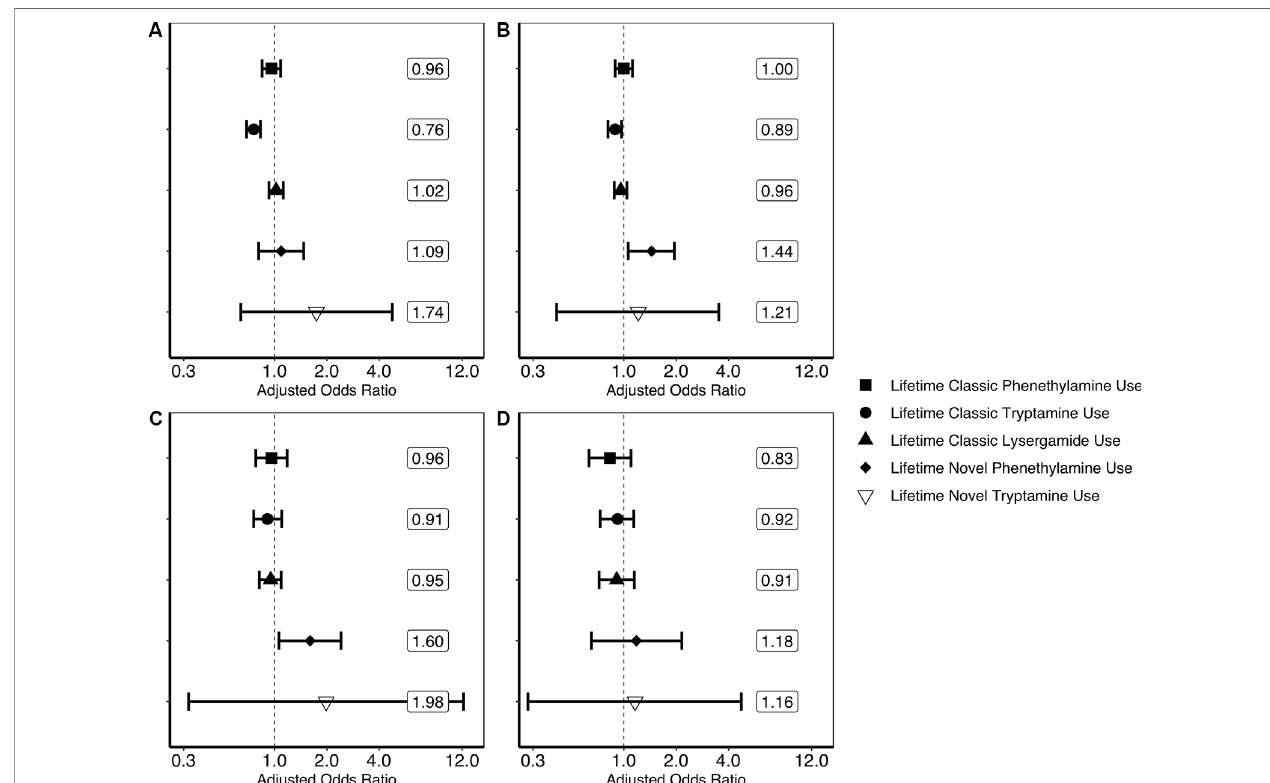
FIGURE 1 | Results of multivariate logistic regression models predicting past month psychological distress and past year suicidality. (A) Result of multivariate logistic regression model predicting past month psychological distress (unweighted n = 356,046). (B) Result of multivariate logistic regression model predicting past year suicidal thinking (unweighted n = 354,580). (C) Result of multivariate logistic regression model predicting past year suicidal planning (unweighted n = 354,555). (D) Result of multivariate logistic regression model predicting past year suicide attempt (unweighted n = 354,552). Each plotted shape relates to the drug category and represent weighted adjusted odds ratio point estimates and error bars are 95% con fi dence intervals. Associations are adjusted for the following covariates: age in years (12 – 17, 18 – 25, 26 – 34, 35 – 49, 50 – 64, or 65 or older); sex (male or female); ethnoracial identity (non-Hispanic White, non-Hispanic African American, non- Hispanic Native American/Alaska Native, non-Hispanic Native Hawaiian/Paci fi c Islander, non-Hispanic Asian, non-Hispanic more than one race, or Hispanic); educational attainment (5th grade or less, 6th grade, 7th grade, 8th grade, 9th grade, 10th grade, 11th grade, 12th grade, freshman college year, sophomore or junior college year, or senior college year or more); annual household income (less than $20,000, $20,000 – $49,999, $50,000 – $74,999, or $75,000 or more); marital status (married, divorced/separated, widowed, or never married); self-reported engagement in risky behavior ( “ How often do you like to test yourself by doing something a little risky? ” ; never, seldom, sometimes, or always); and lifetime use of cocaine, other stimulants, sedatives, tranquilizers, heroin, pain relievers, marijuana, phencyclidine (PCP), 3,4-methylenedioxymethamphetamine (MDMA/ecstasy), and inhalants (each aforementioned drug category coded as separate covariates). Associations of covariates with psychological distress and suicidality are not reported here. The associations of lifetime novel lysergamide use are not evaluated here as noted in the Discussion